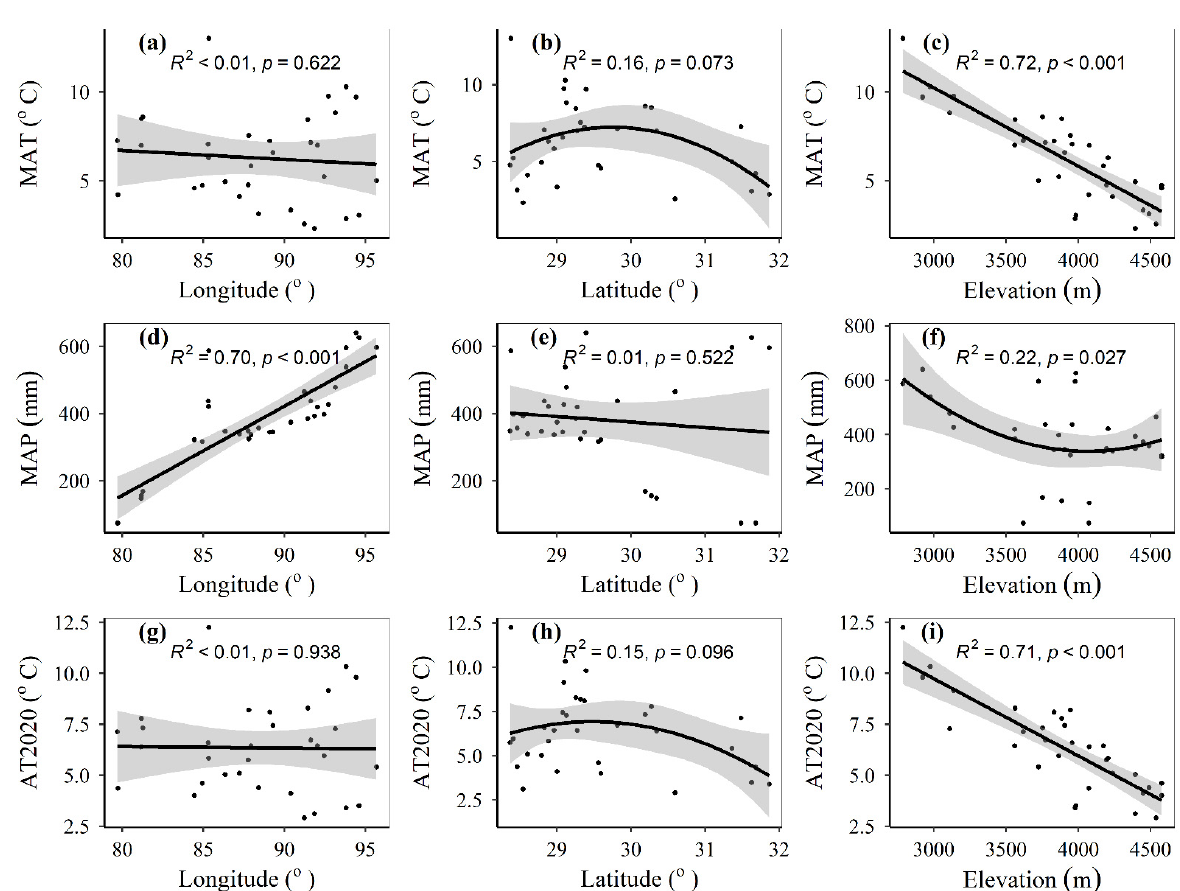
Figure A1. Location of sampling sites in Tibet.